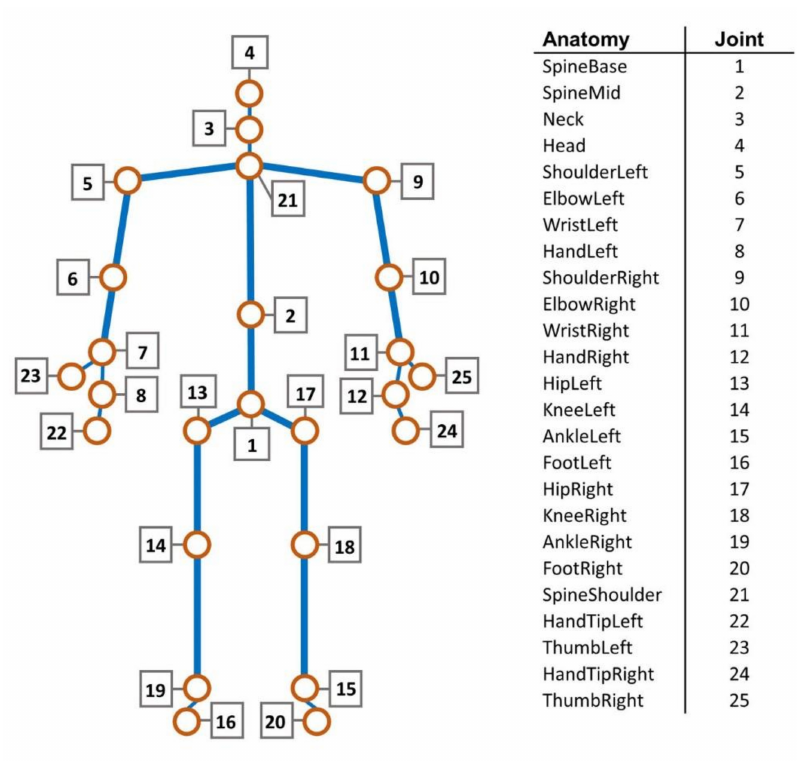
Figure 6. The Kinect 3D skeleton and the anatomical parts corresponding to every joint